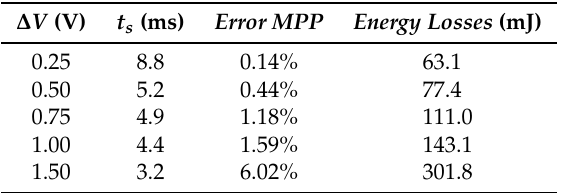
Table 2. Performance of the MPPT algorithm based in